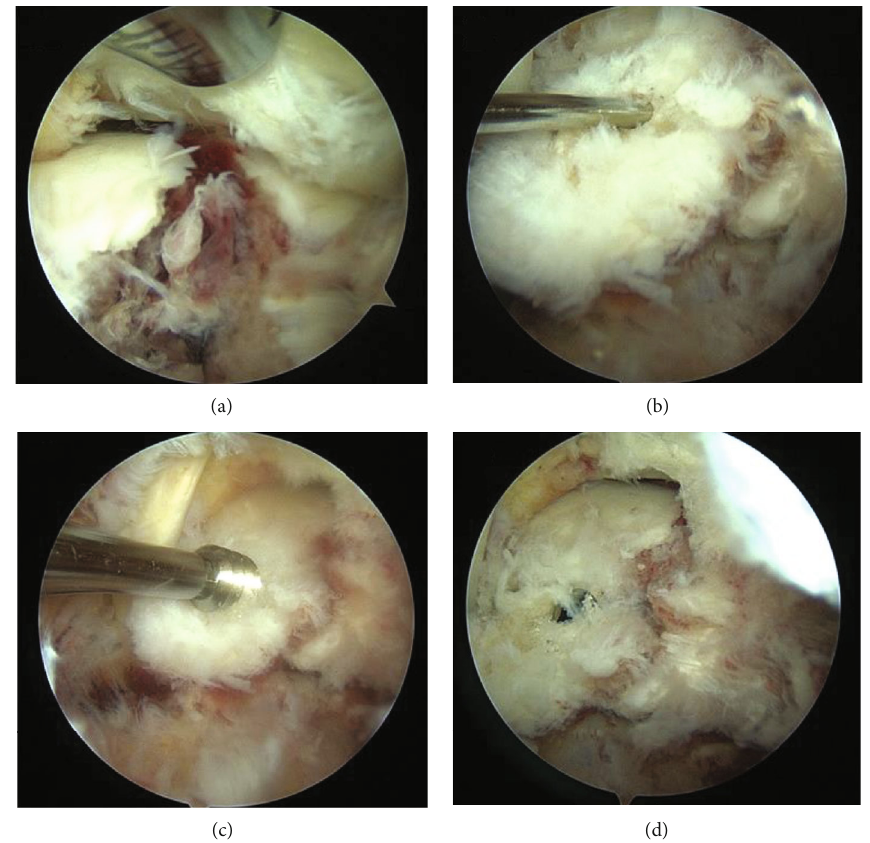
Figure 3: After the posterior aspect of the talus was observed using a 4.0-mm-diameter 30 ° arthroscope, and soft tissues around the talus including synovium, adipose tissue, and coagulation clot were removed with a 4.0-mm-diameter motorized shaver, the fracture site was con fi rmed (a). The fragment was reduced using a guidewire sleeve and fi xed with two 0.8mm guidewires from posteromedial portal (b). Through the guidewires (c), the fragment was fi xed with two cannulated double-threaded screws